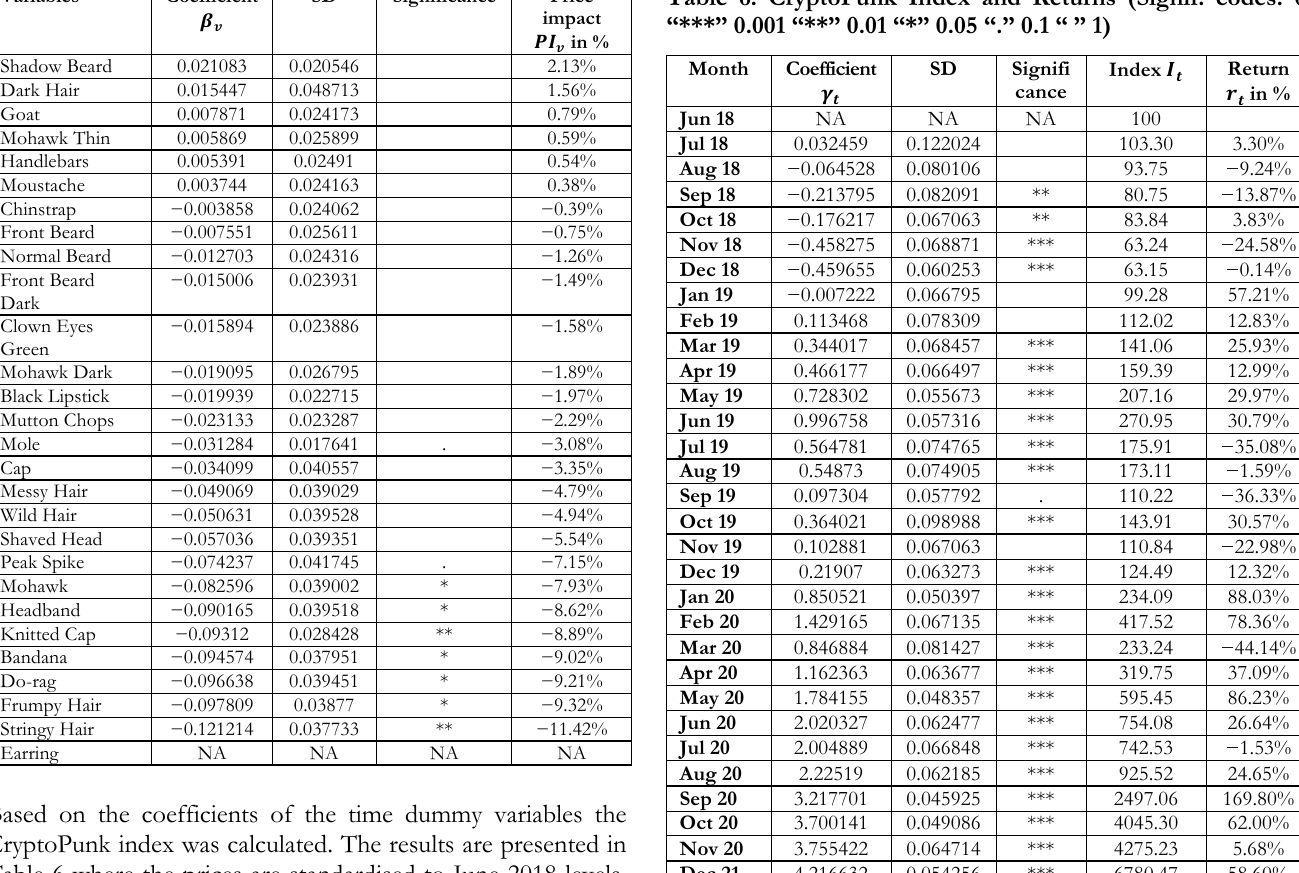
Table 6: CryptoPunk Index and Returns (Signif. codes: